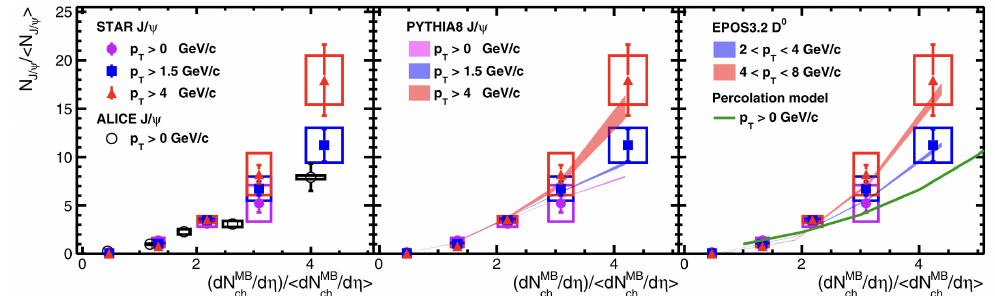
Figure 10. J / ψ production in p + p collisions is shown as a function of multiplicity [59]. The purple data points represent measurements at p T > 0 GeV/c, while the blue (red) data points represent measurements at p T > 1.5 ( p T > 4) GeV/c. In the left panel only, the open data points represent ALICE measurements at p T > 0. The data are compared with different Monte Carlo calculations described in the text. Reprinted with permission from